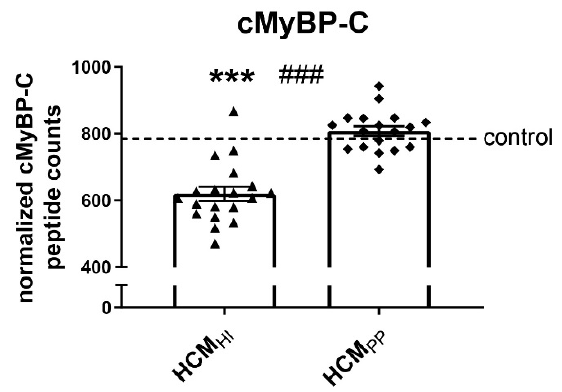
Figure 4. cMyBP-C haploinsufficiency. Mass spectrometry-based proteomics analysis revealed lower levels of cMyBP-C in HCM HI ( n = 19) compared to controls ( n = 5) and HCM PP ( n = 18). Each dot on the scatter plot represents an individual sample. *** p < 0.001 versus controls and ### p < 0.001 versus HCM PP . Table 4. Overview of results on statistical testing for differences between HCM HI and HCM PP .